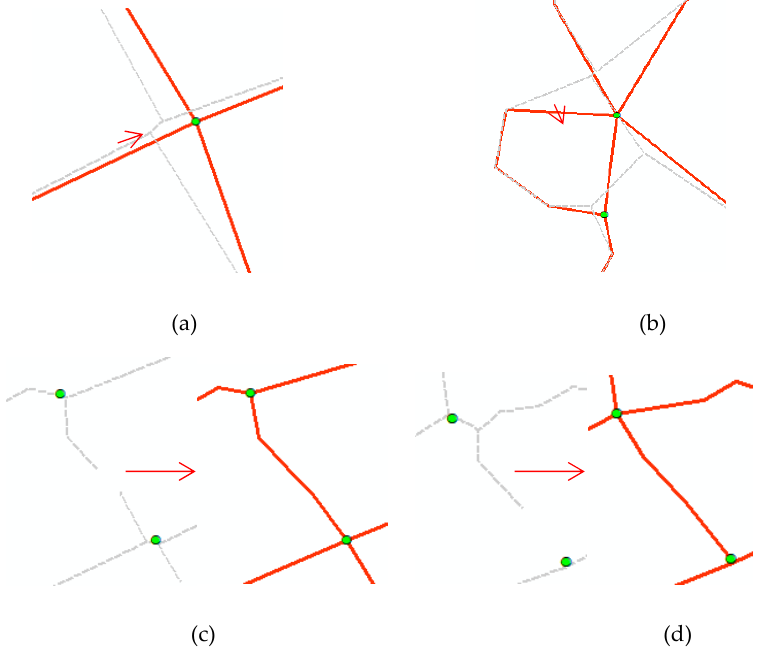
Figure 12. Some examples for road segment improvement around intersections (gray is the pre- correction road segments and red is the corrected road segments): ( a ) Position and shape correction; ( b ) position and shape correction; ( c ) connecting fractured segments; ( d ) connecting fractured